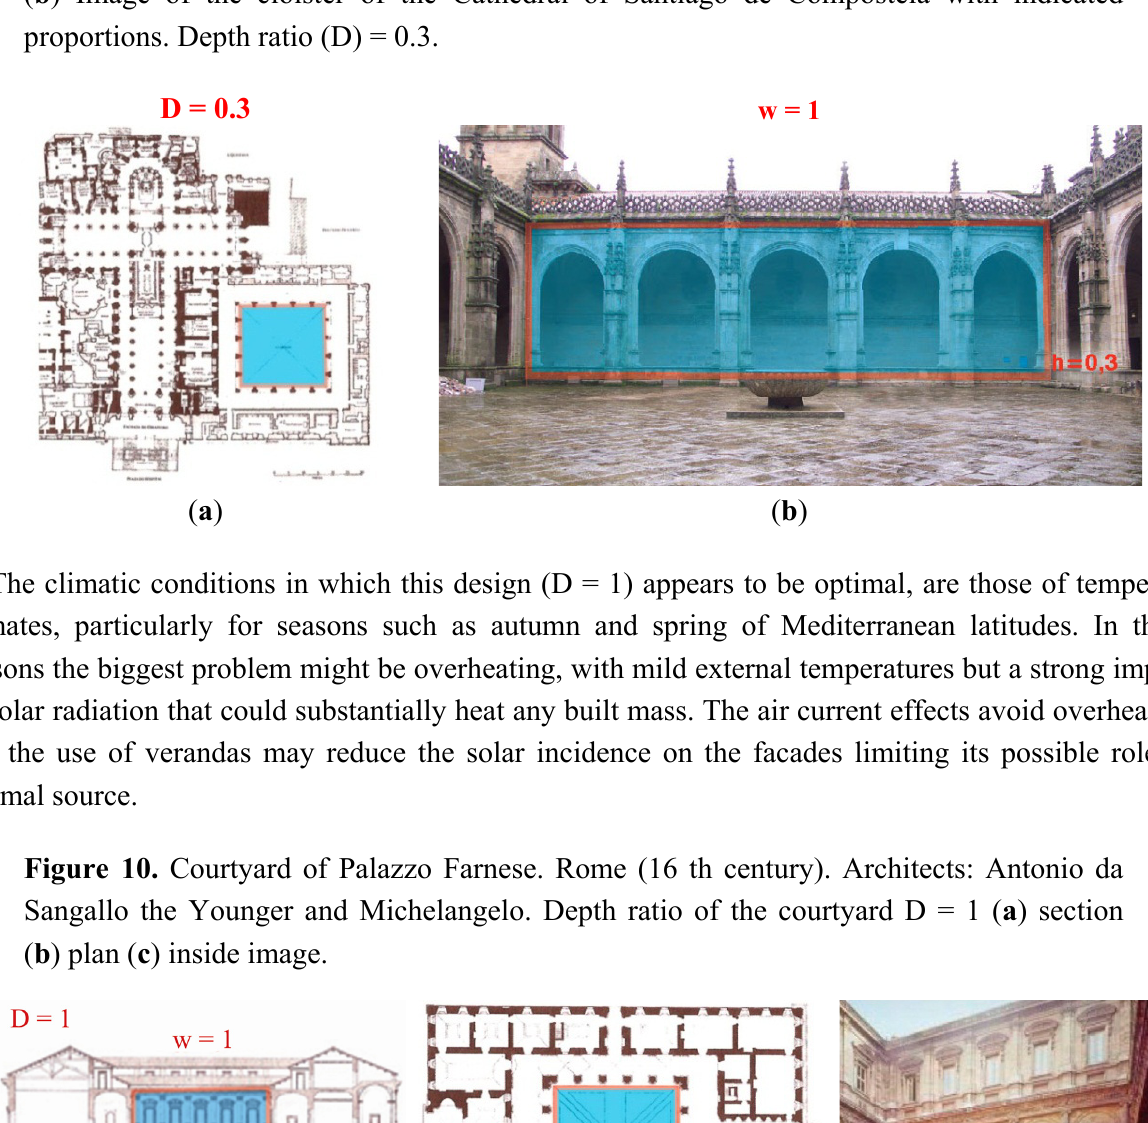
Figure 9. ( a ) Plan of the Cathedral of Santiago de Compostela, Galicia, north of Spain; ( b ) Image of the cloister of the Cathedral of Santiago de Compostela with indicated proportions. Depth ratio (D) = 0.3.